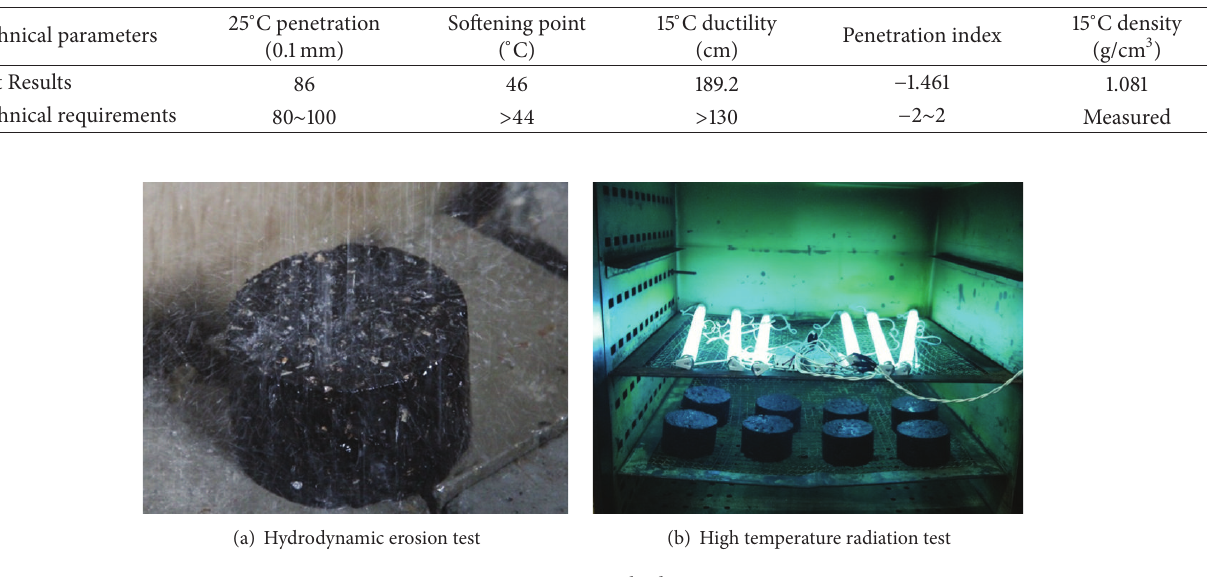
Figure 3: Pretreatment method on specimen.